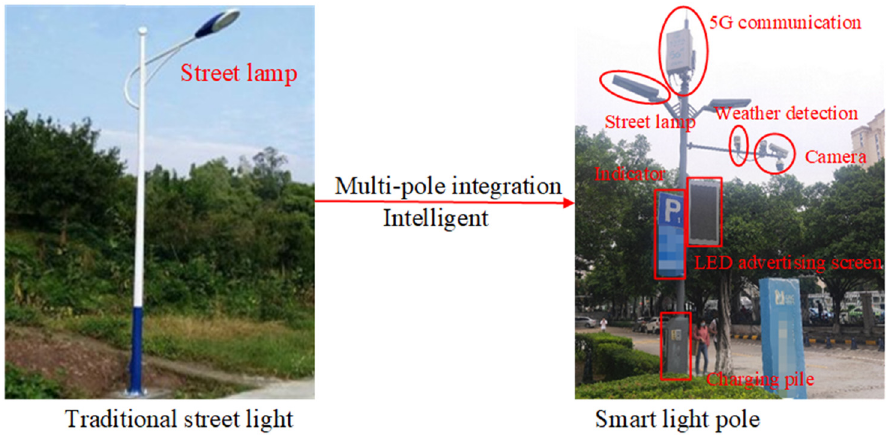
Figure 1: The di ff erence between the smart light pole and the traditional light